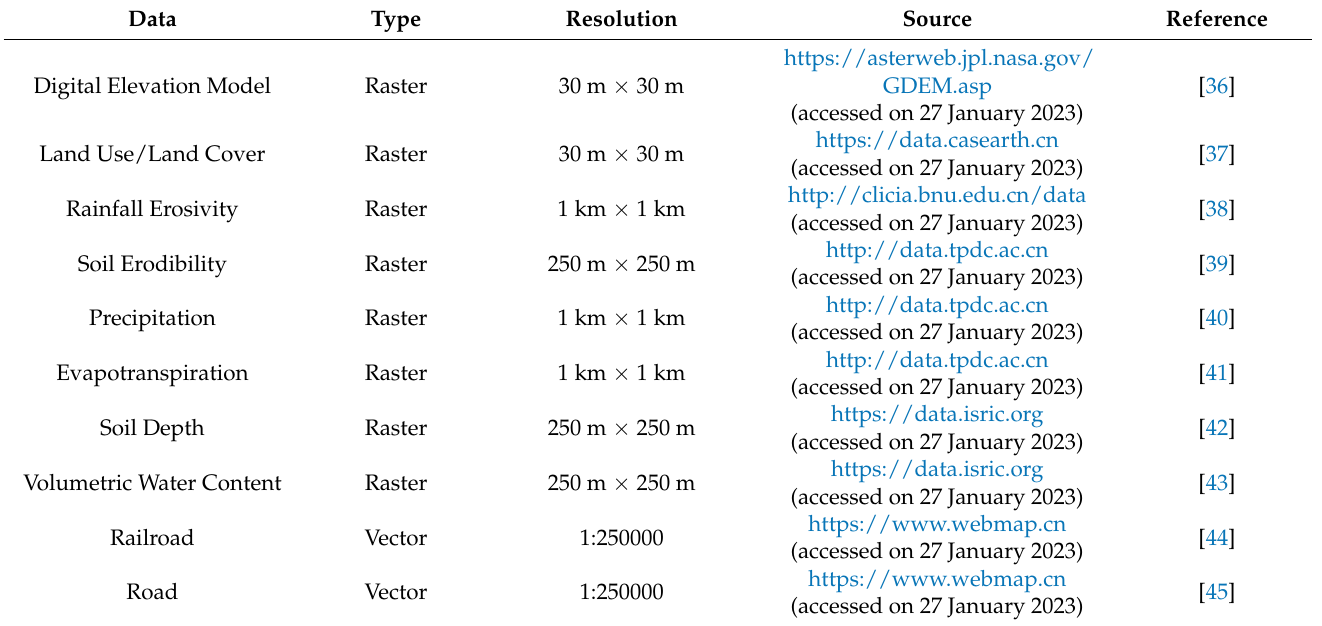
Table 1. Multi-source spatial